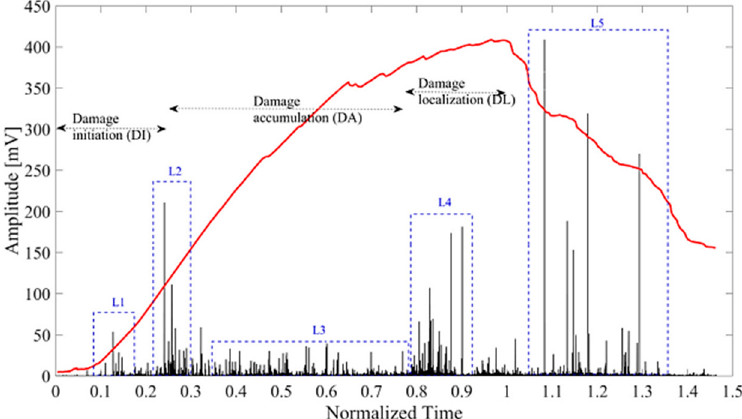
Figure 15. AE signal indicating the load vs. time [183] (Reprinted/adapted with permission from Elsevier Ref.5457241510623 Copyright 2021).